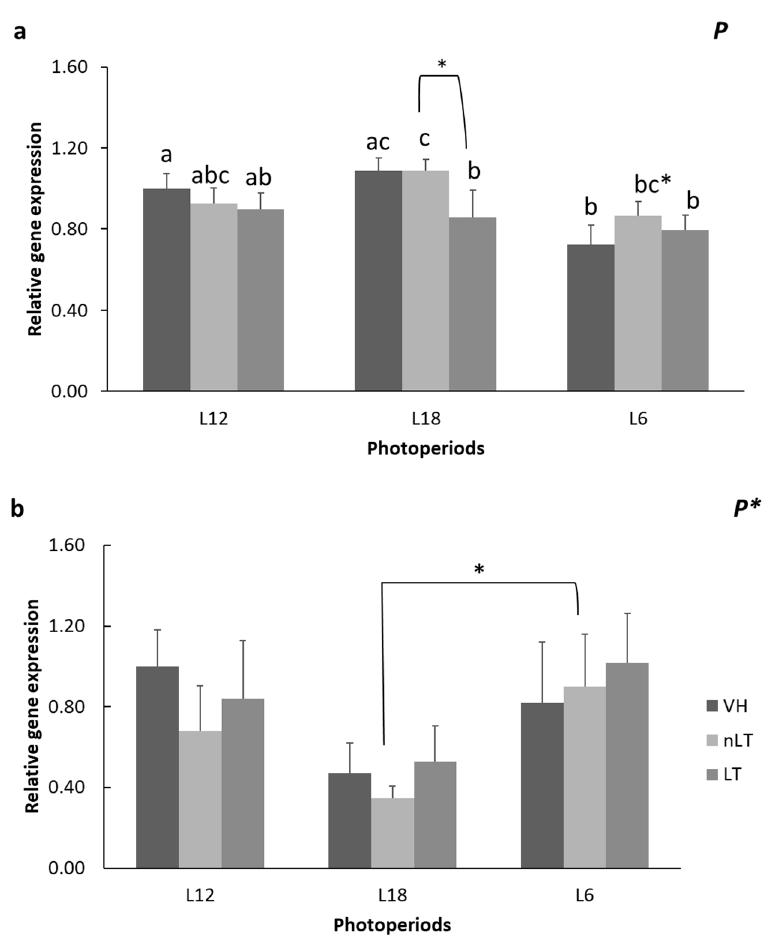
Figure 3. The mRNA levels of sterol regulatory element-binding protein 1 (Srebp-1c) ( a ) and carnitine palmitoyltransferase 1- α ( Cpt1 α ) ( b ) of male Fischer 344 rats treated for 7 weeks with vehicle (VH), non-local tomatoes (nLT), or local (LT), and exposed to different photoperiods (short: L6, standard: L12, or long: L18). Values expressed as mean ± SEM ( n = 8). The values were normalized by the L12-VH group. P, photoperiod effect (two-way ANOVA, p < 0.05). Different letters above the bars indicate significant differences ( p < 0.05) (post hoc DMS, one-way ANOVA). * Indicate trend (0.05 < p < 0.1).